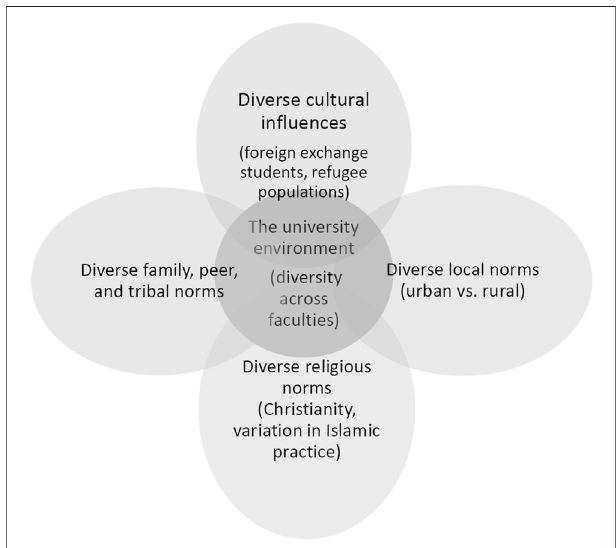
FIGURE 2 | Factors in fl uencing the diversity of campus